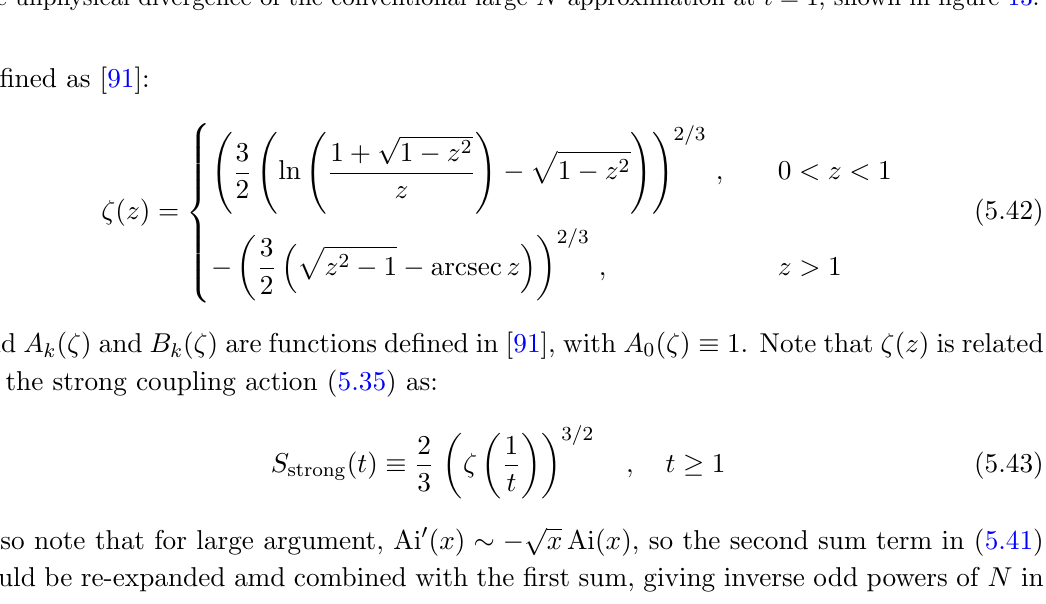
Figure 12 . The exact Bessel function J 5 (5 =t ) as a function of t [blue solid curve], compared with the leading term of the uniform expansion (5.41) [red dashed curve]. The curves are indistinguishable in this plot. The black dotted curves show the leading terms of the Debye expansion [90], which diverge at t = 1. This divergence is an artifact of the Debye approximation and is responsible for the unphysical divergence of the conventional large N approximation at t = 1, shown in (cid:12)gure